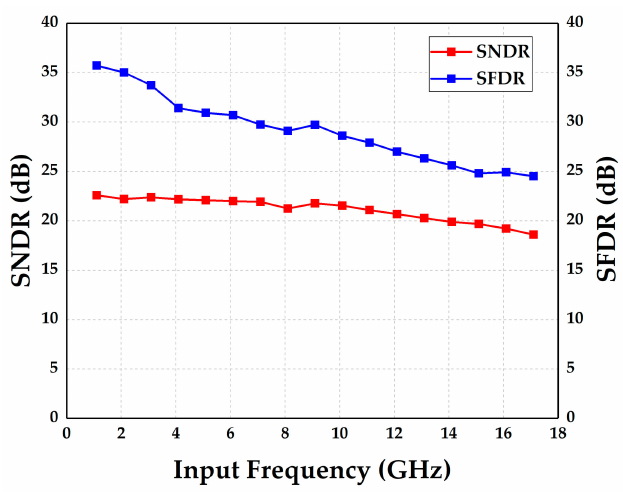
Figure 19. SNDR / SFDR of the ADC versus frequency of the input signal at 36 GS / s. Table 1. Performance comparison with state-of-art